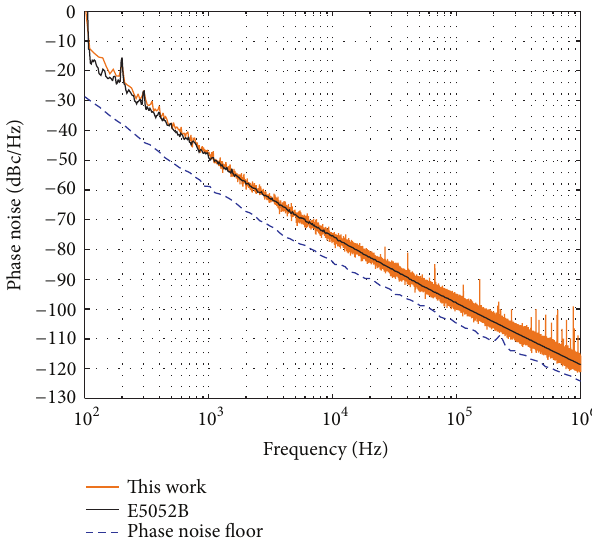
Figure 14: Phase noise measurements of a VCO from HITTITE- HMC587LC4B ( 𝑃 𝑖𝑛 = −2